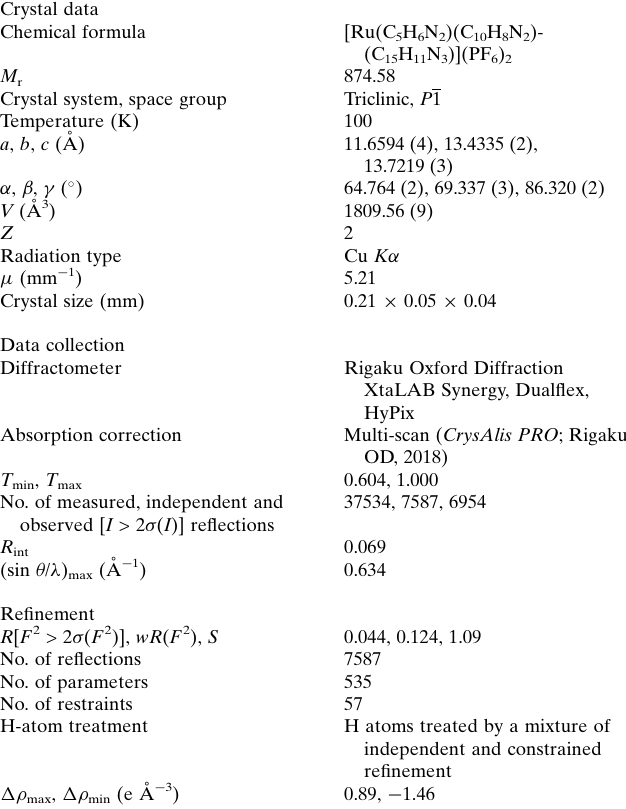
Table 3 Experimental details. Crystal data Chemical